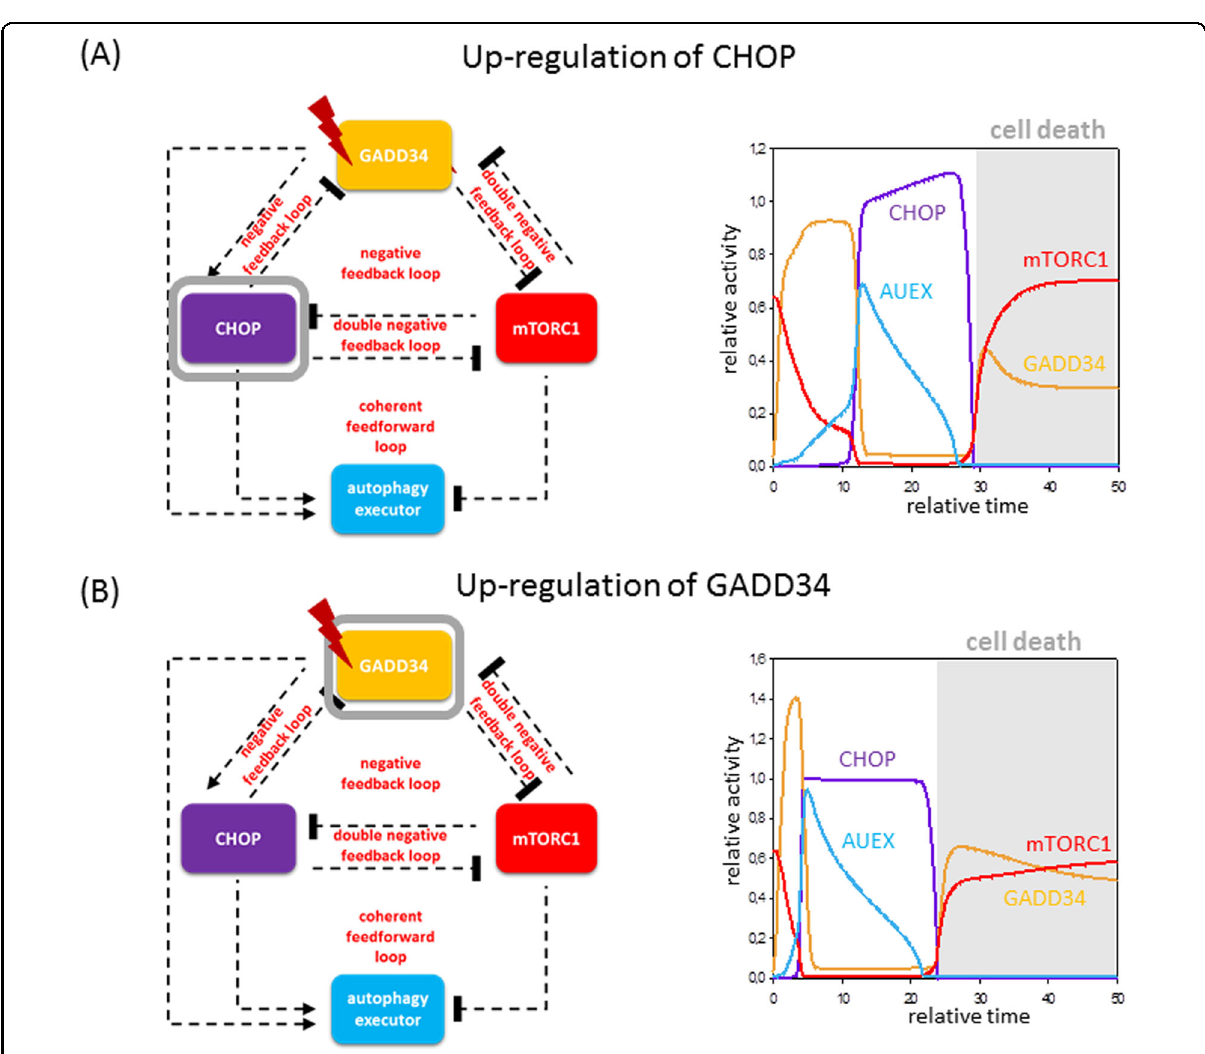
Fig. 3 Both GADD34 and CHOP have important functions at endoplasmic reticulum stress: upregulation of CHOP or GADD34. The computational simulations are determined in the overexpression of A CHOP and B GADD34 upon excessive levels of cellular stress. The temporal dynamics is simulated with high stress (stress = 9) combined with A CHOP-T = 1.25 or B GADD34-T = 2. Grey background refers to possible cell death. For details about the codes and software used for simulations, see the Supplementary